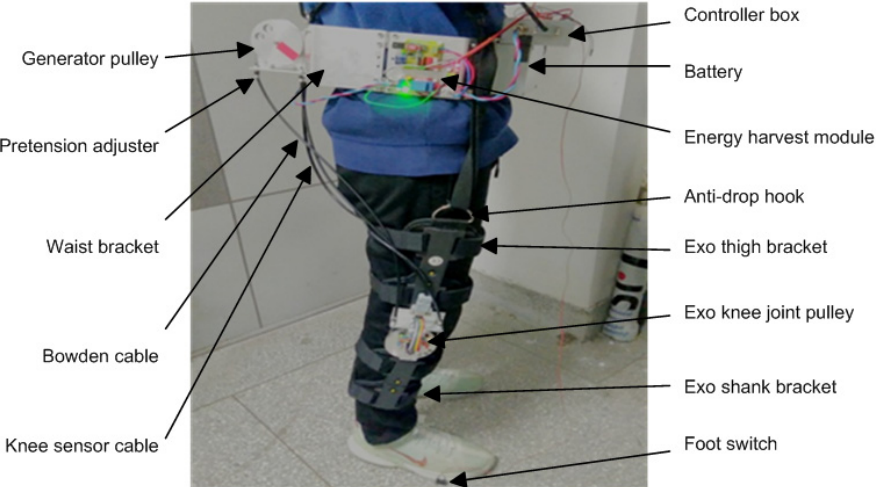
Figure 12. Side view of the prototype of the Bowdencable-actuated knee exoskeleton and the human subject (in a standing position).